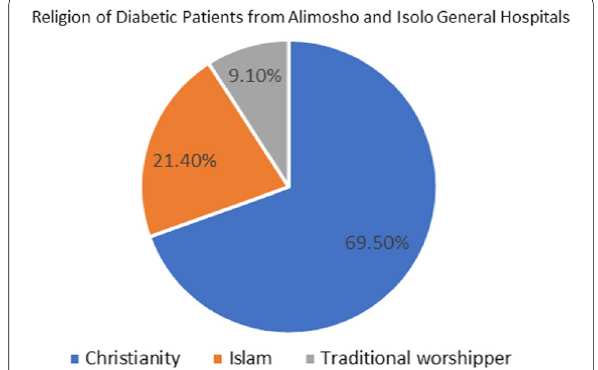
Fig. 2 Religions of diabetic patients in Alimosho and Isolo General Hospitals